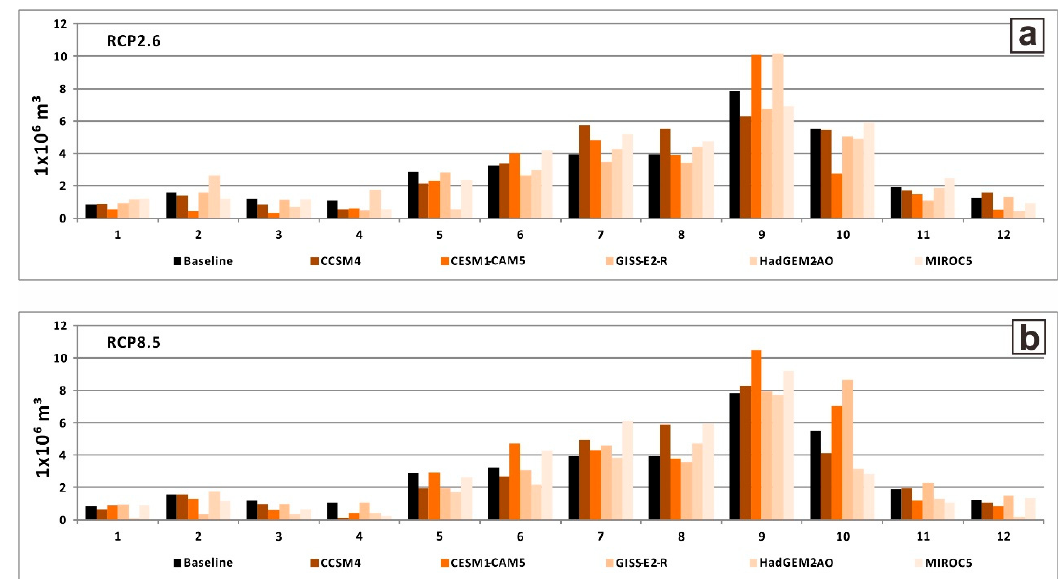
Figure 3. The monthly water yield under different climate change scenarios ( a ) RCP2.6 and ( b ) RCP8.5.